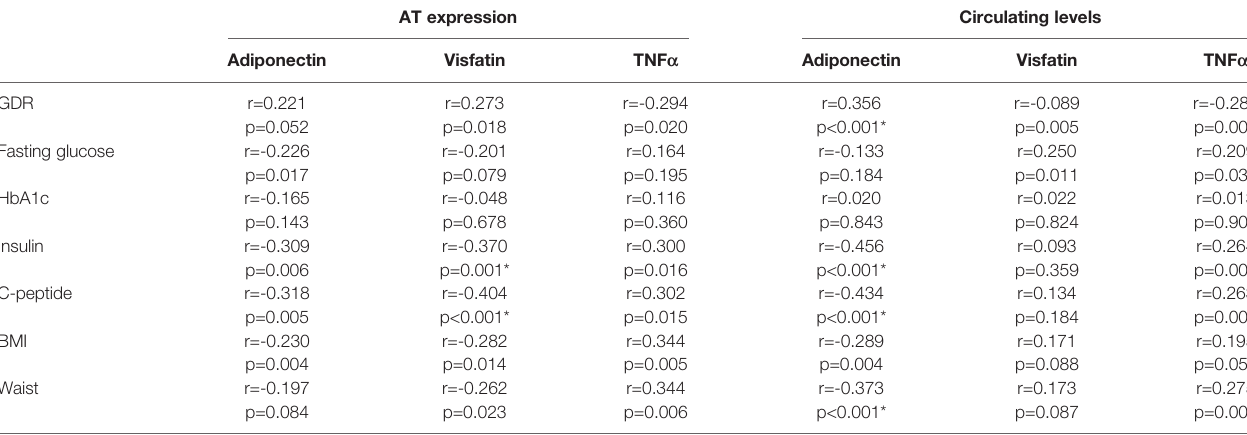
TABLE 3 | Correlations (Spearmans Rho) between glucometabolic variables and the investigated